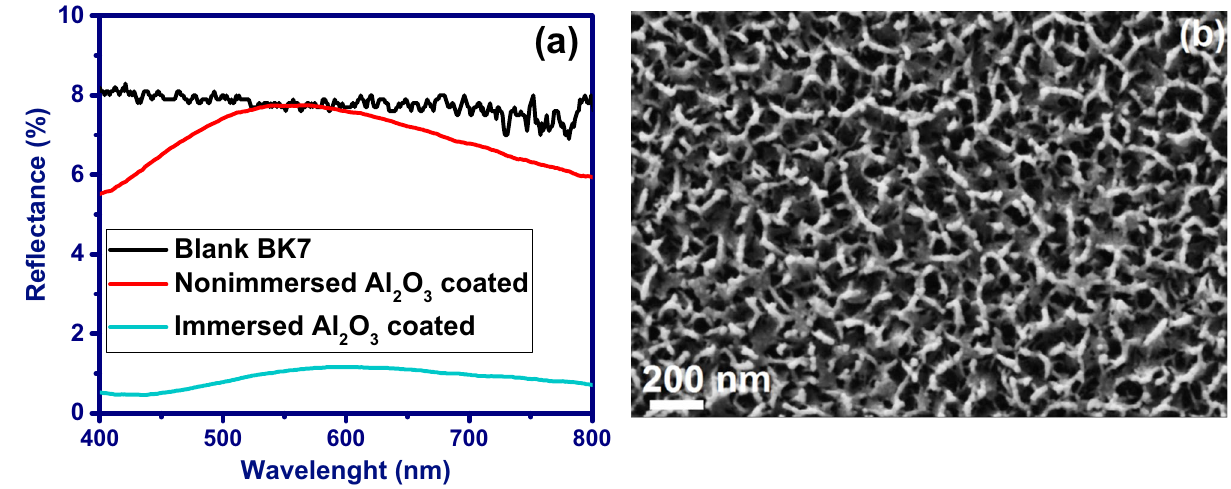
Figure 1. ( a ) Reflectance spectra measured from blank BK7 and double-side Al 2 O 3 coated BK7 substrates with and without hot-water treatment. ( b ) Field emission scanning electron micrograph of the surface of Al 2 O 3 thin film with boomerang-like